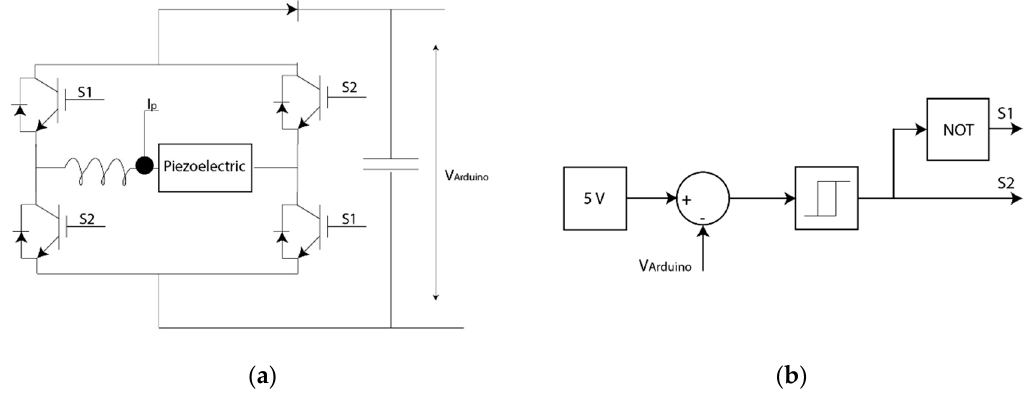
Figure 14. Electronic circuit for the maximum power: ( a ) electronic circuit and ( b ) relay control of the voltage of the low-cost bus.